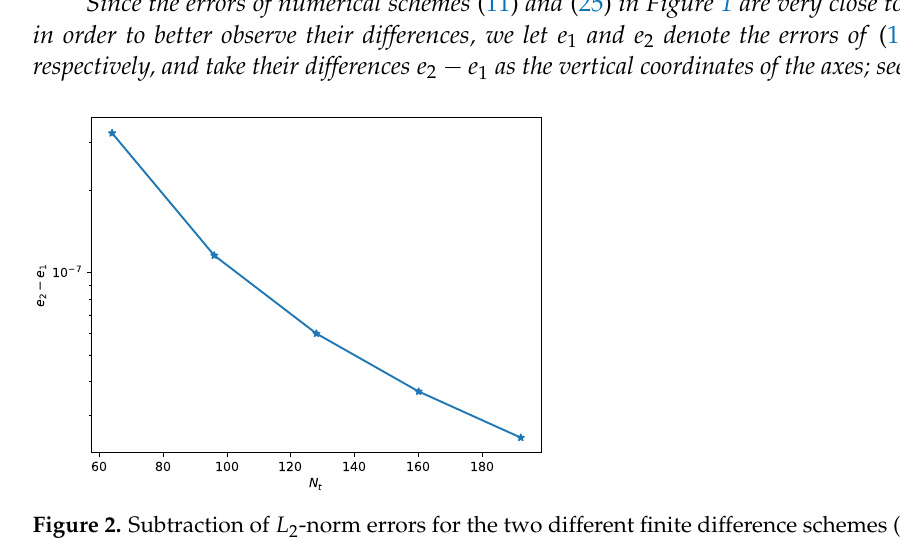
Figure 2. Subtraction of L 2 -norm errors for the two different finite difference schemes (11) and (26) with fixed α = 0.3 (Here, e 1 and e 2 denote L 2 -norm errors in (11) and (25),